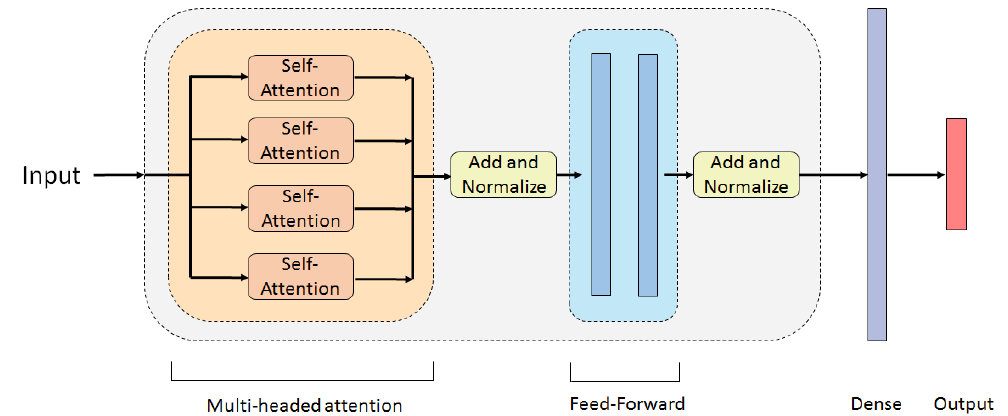
Figure 5. Architecture of the Transformer model.